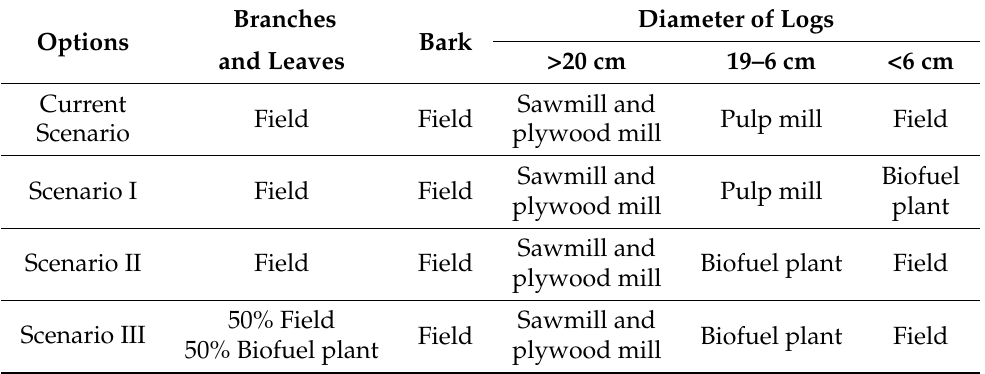
Table 7. Potential feedstocks scenarios using different fractions of